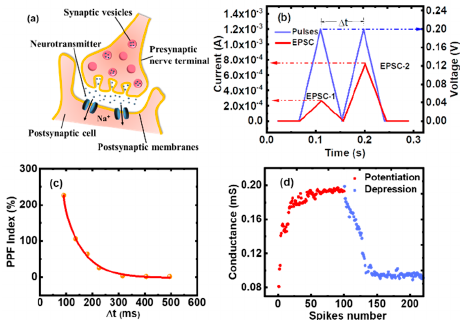
pulse width of 90 ms. The red curve is the corresponding responses of the paired-pulse facilitation (PPF) characteristic, and the excitatory postsynaptic current (EPSC)-2 is significantly enhanced. ( c ) The relationship between the index of PPF and pulse intervals ∆ t , displaying an exponential decrease. ( d ) The long-term potentiation (red scatters) and long-term depression (blue scatters) characteristics of the Ag / MXene / SiO 2 / Pt RRAM